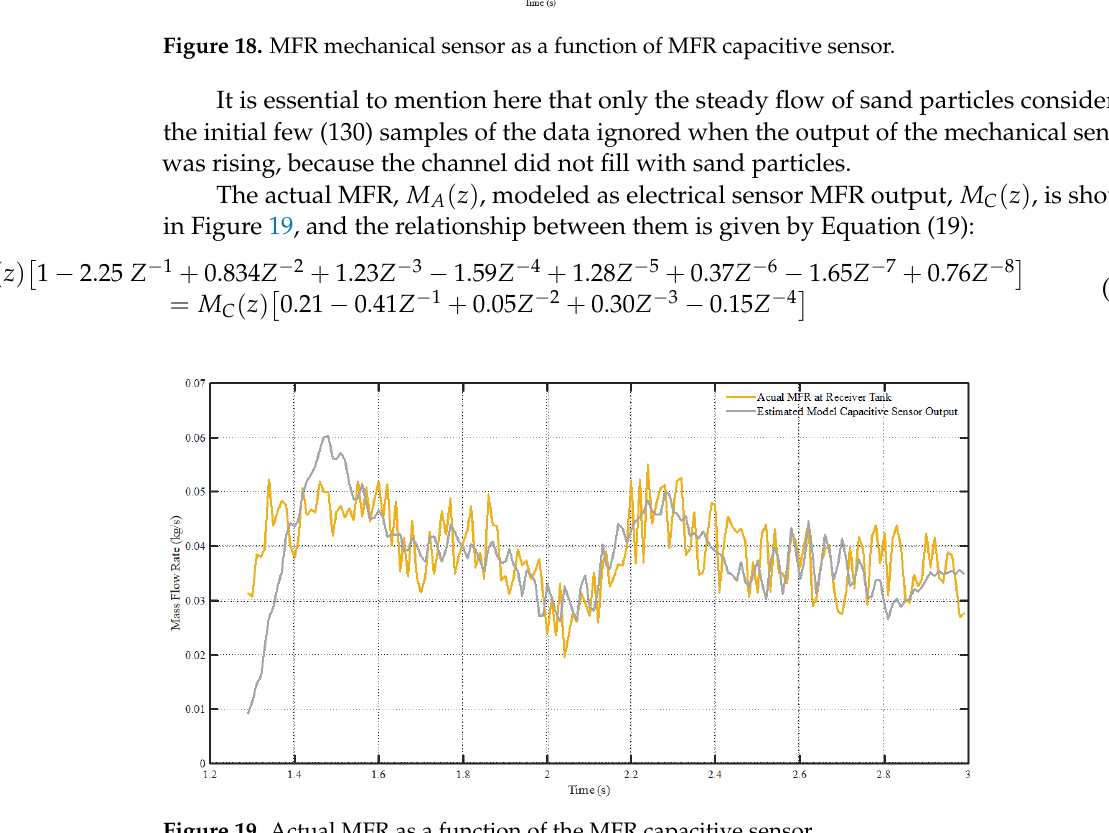
Figure 20. Actual MFR as a function of the MFR mechanical sensor. Figure 20 correlates actual MFR values with the mechanical sensor and capacitor sensor. In the case of mechanical sensors, the changes in the readings are very slow, so in order to model the mechanical sensor value to the real value, it required previous sam- ples of both the mechanical sensor and real values in order to minimize the error through an iterative process. However, the variation in the electrical sensor values is quite fre- quent, in accordance with the real values, but is accompanied by external noise/disturbance, as shown in Figure 19. The iterative error reduction process required previous samples of both real values and sensor values to predict the current sensor value closer to the actual value with the least possible error.